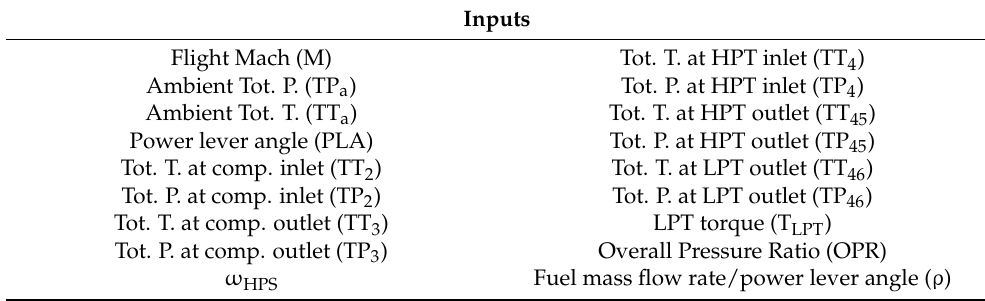
Table 4. Variables used as input for the developed EHM system. Tot. T: Total Temperature; Tot. P.: Total